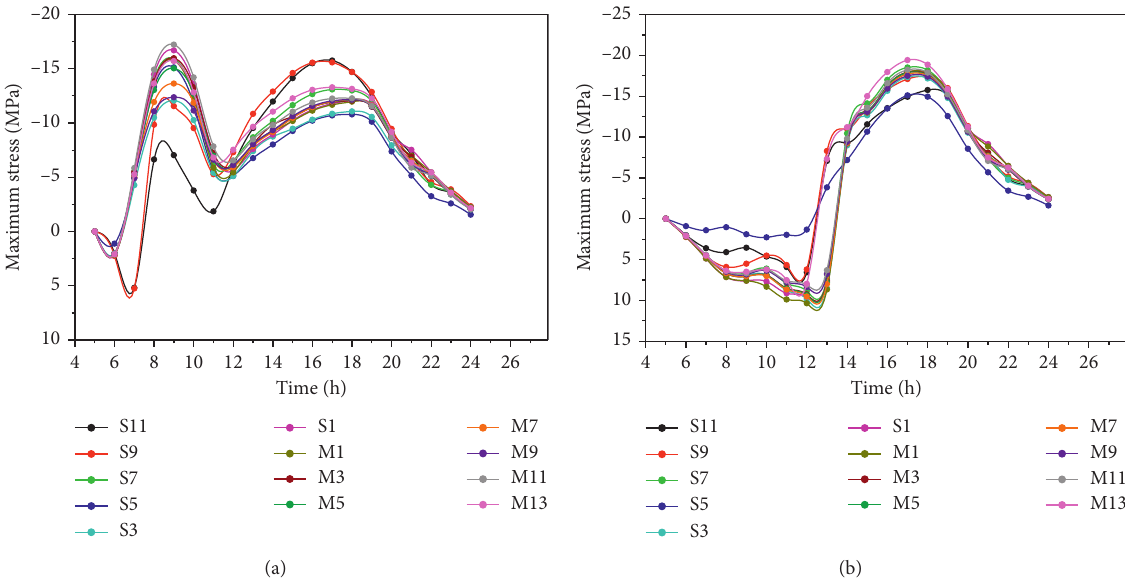
Figure 18: The maximum stress variation of the top plate of each segment. (a) The maximum stress variation of the top plate of each segment at the west side. (b) The maximum stress variation of the top plate of each segment at the east side.